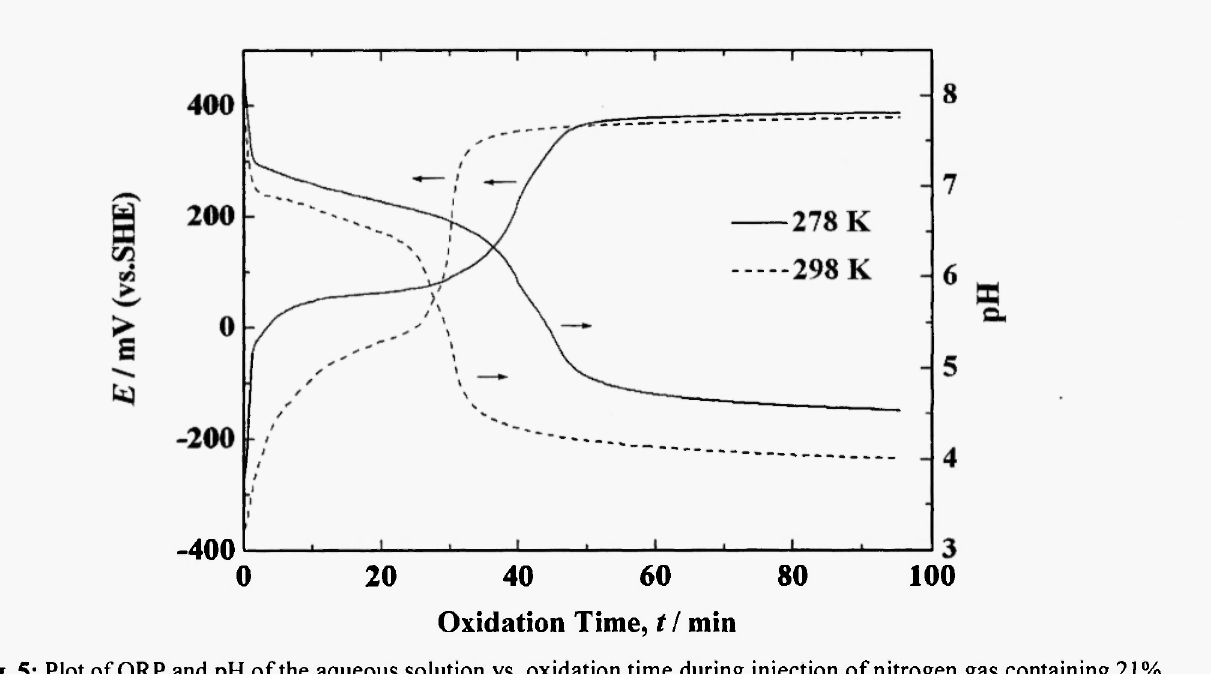
Fig. 5: Plot of ORP and pH of the aqueous solution vs. oxidation time during injection of nitrogen gas containing 21% oxygen into the GR2(S0 4 2 ~) suspension at 278 and 298 K. second stage, oxidation at 298 Κ appears at about 30 min, which is faster than that at 278 K. These characteristic changes in ORP and pH values are likely to affect the formation of different oxyhydroxides in the GR2(S0 4 2_ )